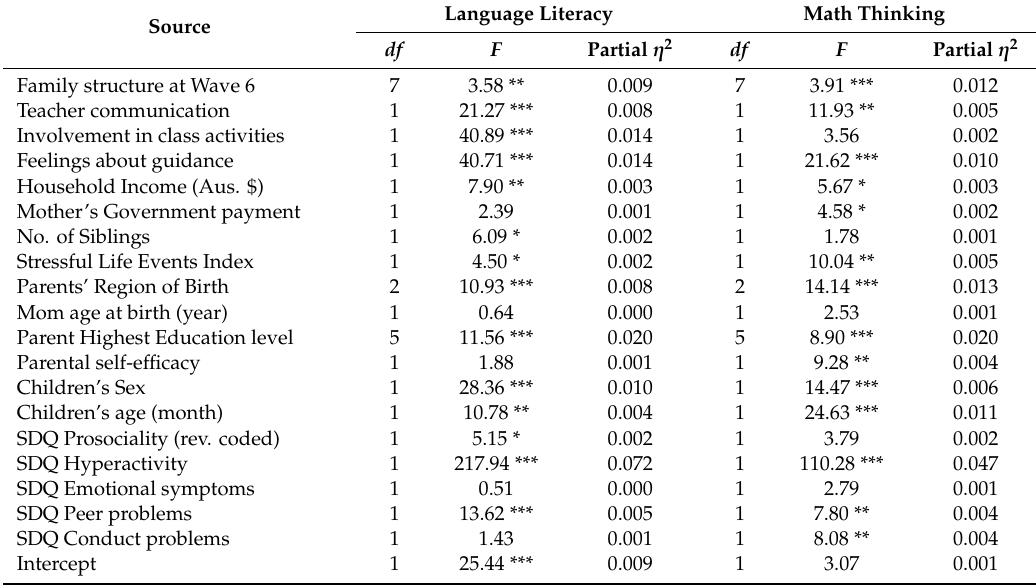
Table 6. ANCOVA results of two academic outcome subscales